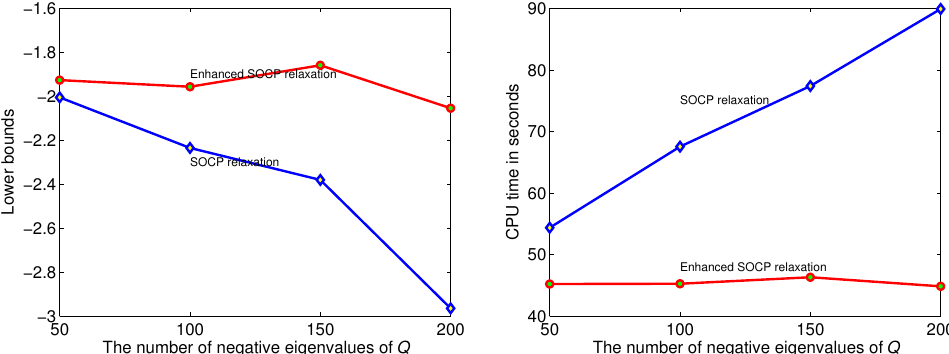
Figure 1. Comparisons of lower bounds and computing time between (6) and (8) with varying dimensions of variables.